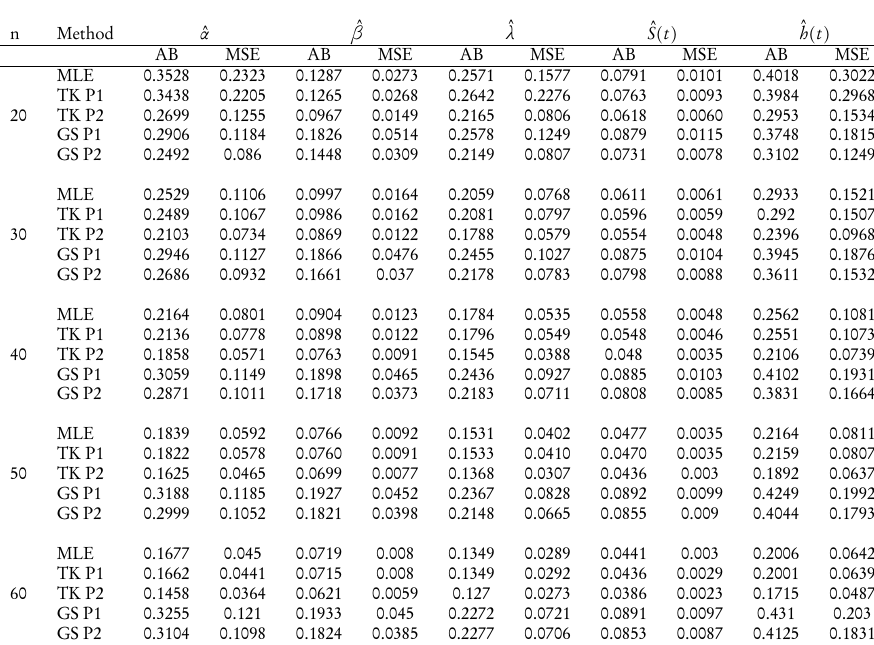
The ML and Bayes estimates of parameters and reliability characteristics when α = 2, β = 0.5, λ =